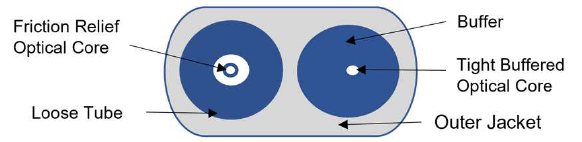
Figure 2. Cross section of fiber optic cable for physical strain and temperature measurement.